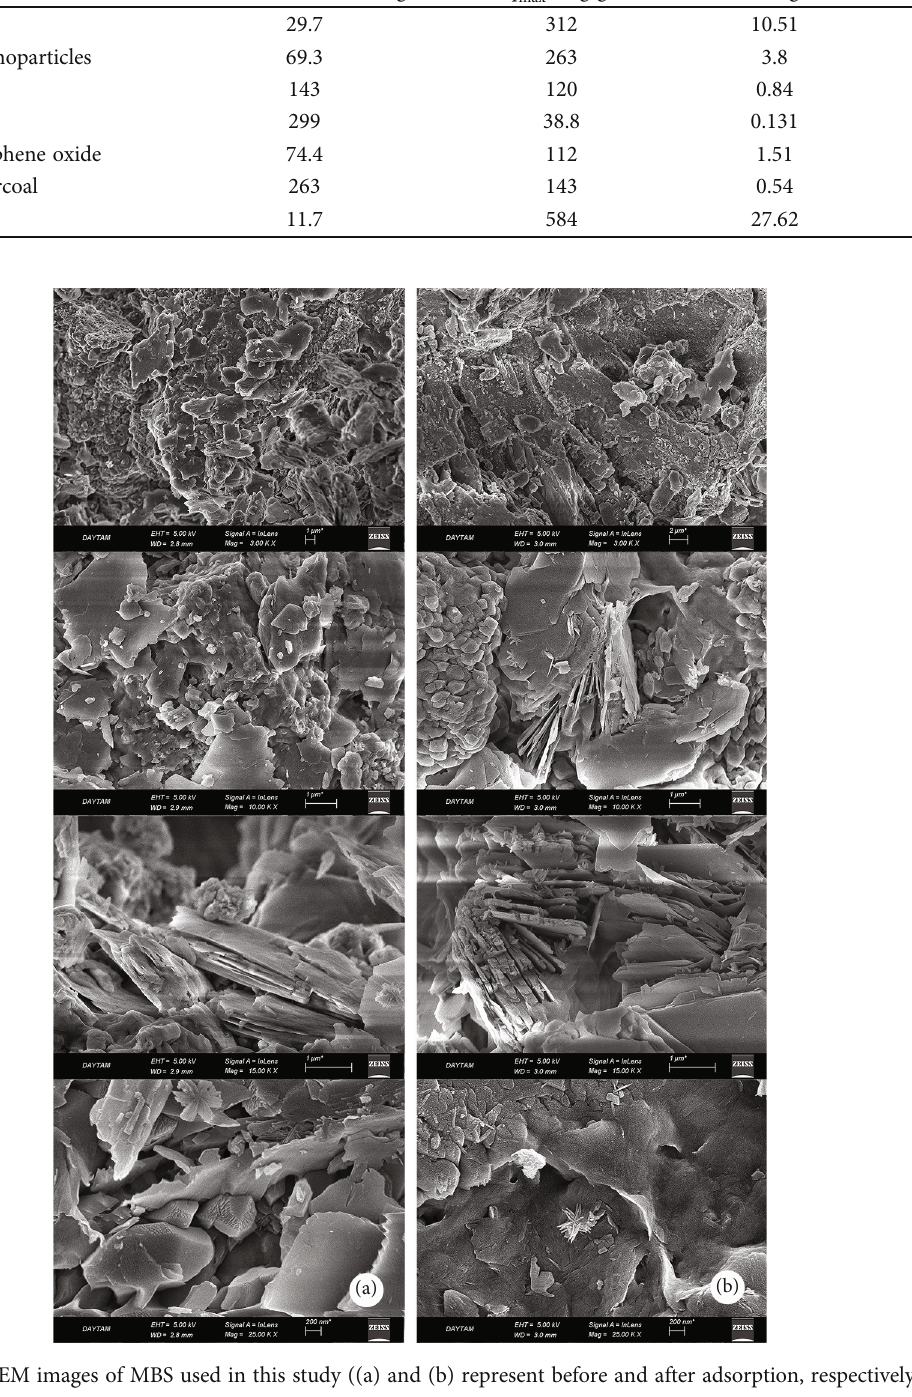
Table 3: Surface area and q Adsorbent